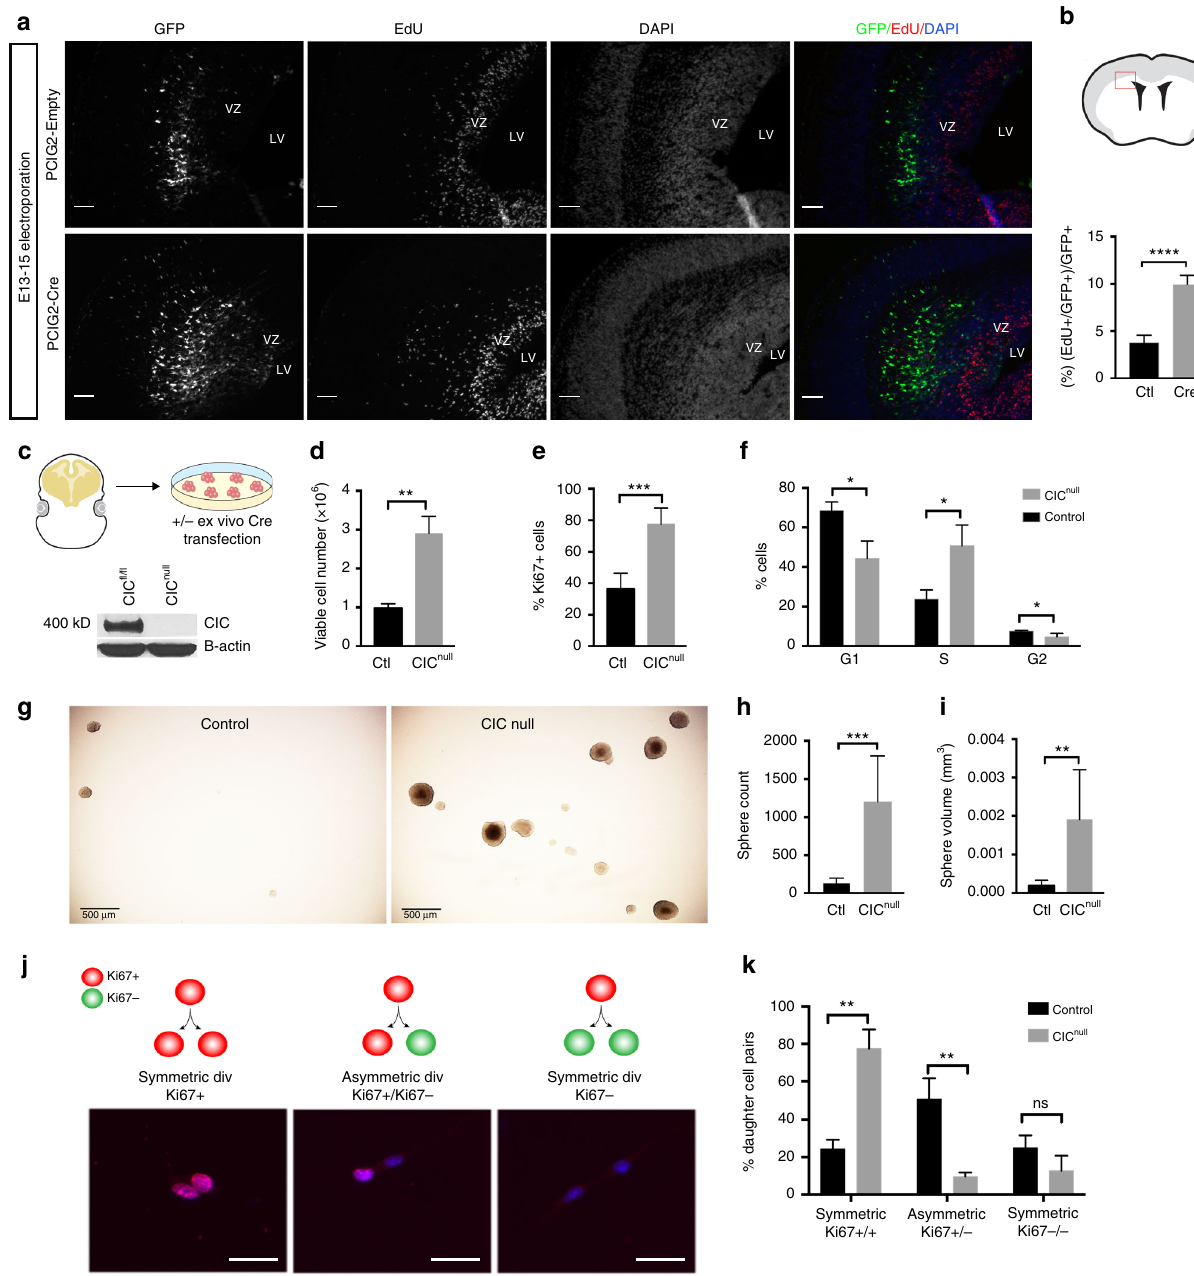
Fig. 3 Cic de fi ciency increases proliferation and self-renewal of neural stem/progenitor cells. a , b EdU incorporation 48-hours after electroporation of Cre or control plasmid into VZ of E13 Cic- fl oxed embryos; a representative images of staining and b quantitation in boxed zone; n = 4 for pCig-cre, n = 5 for control; scale bar: 50 μ m. c Generation of Cic-null cells and control cells from Cic - fl oxed cells via ex vivo transfection of Cre recombinase, and western blotting for validation of knockout. d – f Cell proliferation measured by Trypan blue assay d , Ki67 proliferation index e , and propidium iodide cell cycle analysis f in cultured cells; n = 3 biologic replicates. g – i Neural colony-forming assay, representative images g and quantitation of sphere number h and sphere size i from n = 3 biologic replicates; scale bar: 500 μ m. j – k Paired cell assay schematic and representative images of Ki67 immunostaining j , and quantitation of symmetric proliferative, asymmetric, and symmetric terminal divisions k ; data from n = 3 biologic replicates per condition; scale bar: 20 μ m. Source data are provided as a Source Data fi le. Data shown as mean ± SD. ns – not signi fi cant, * p < 0.05, ** p < 0.01, *** p < 0.001, **** p < 0.0001. Labels: VZ – ventricular zone, LV – lateral ventricle Cic regulates NSC cell division asymmetry . During neurodeve- of cell division, and the fraction of cells remaining in or exiting lopment, the NSC pool is fi rst expanded by symmetric pro- the cell cycle. Both Cic -null and control NSCs generated spheres, liferative divisions, followed by rounds of asymmetric divisions of but Cic -null NSCs generated more spheres (Fig. 3g, h) and larger stem and progenitor cells generating neurons and glia, and fi nally spheres (Fig. 3g, i) compared with controls. Thus, Cic loss confers by terminal symmetric differentiative divisions 18 . The balance not only higher proliferation but higher self-renewal in NSCs, at least when cells are in conditions promoting NSC proliferation. between symmetric and asymmetric divisions is important; NATURE COMMUNICATIONS| (2019) 10:2000